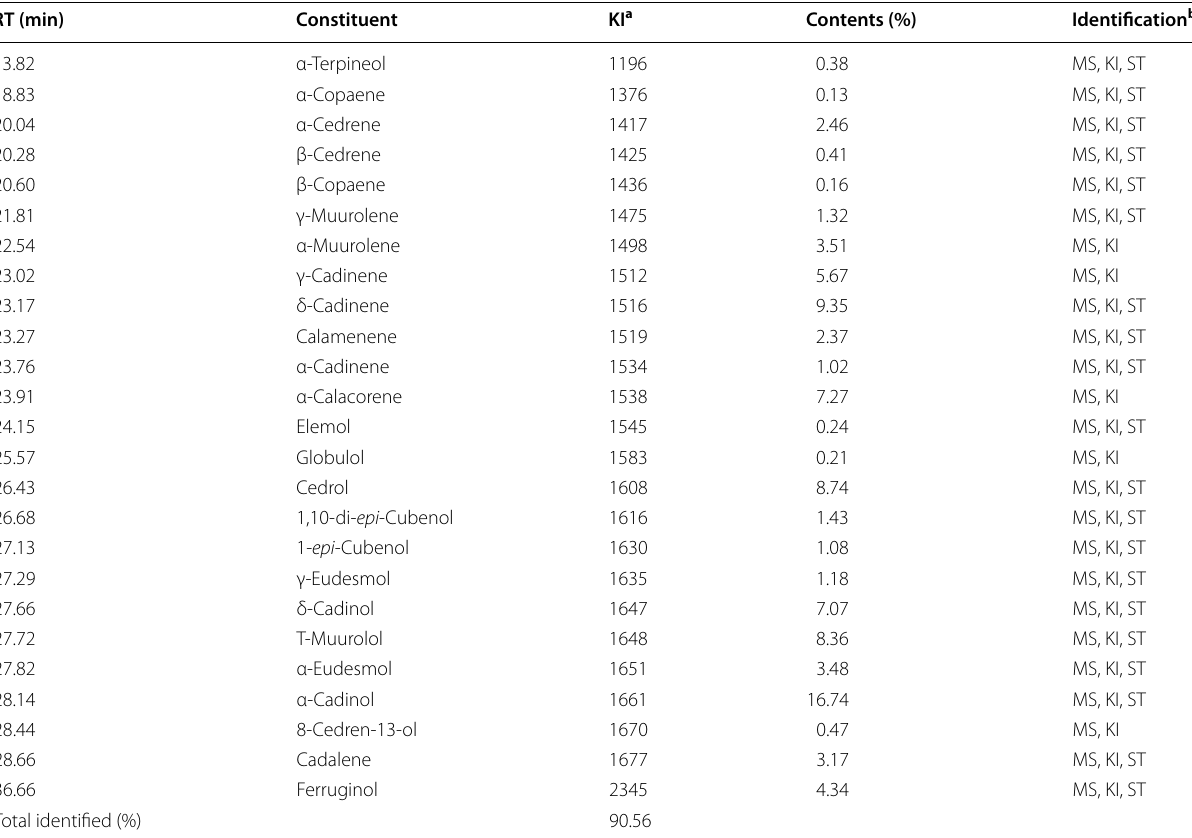
Table 1 Chemical composition of the essential oil of sapwood of